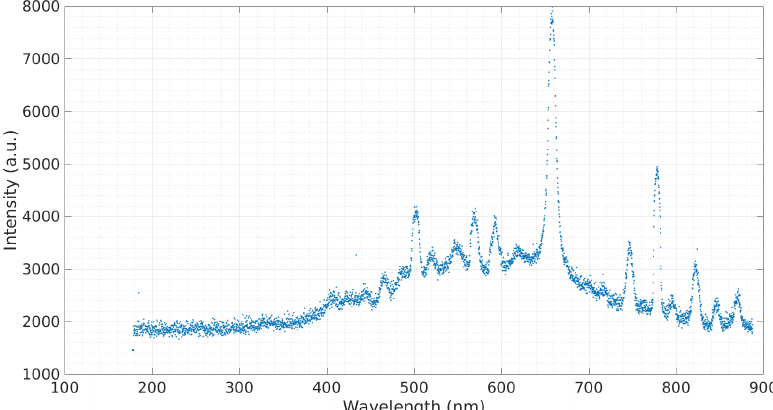
Figure 4. Emission spectra of Ca(NO 3 ) 2 in deionized water.